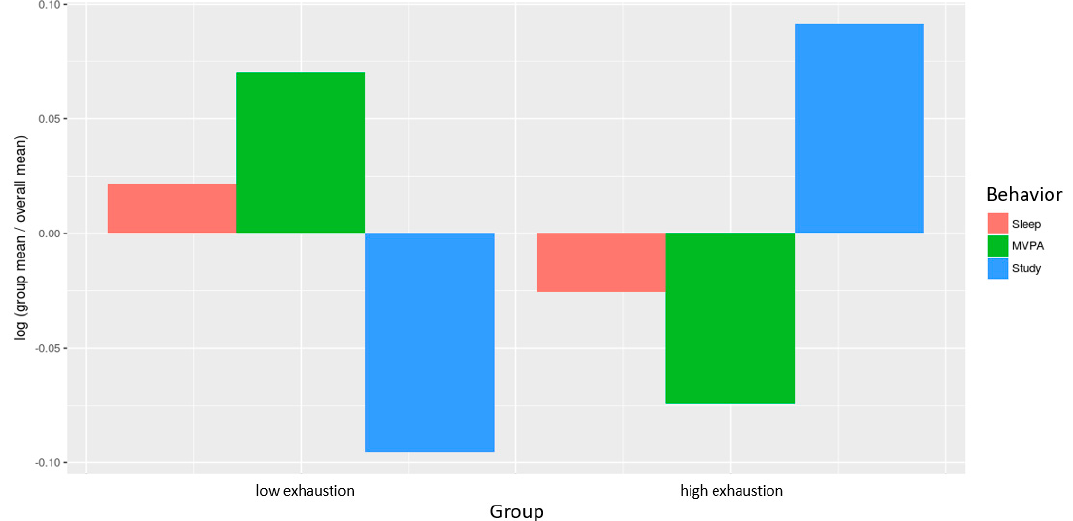
Figure 2. Composition of the day by groups of low and high emotional exhaustion (median split) as compositional analysis of the relative importance of the group mean time spent in sleep, MVPA, and study with respect to the overall mean time composition. The y axis displays the log-ratio value.